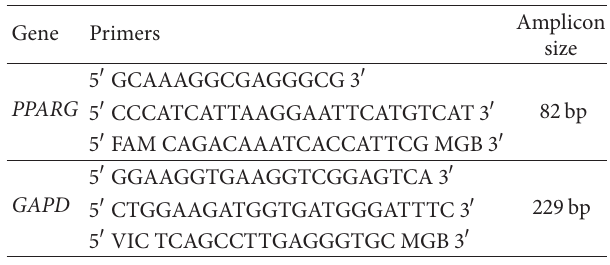
Table 1: Primers and probes used for mRNA expression by